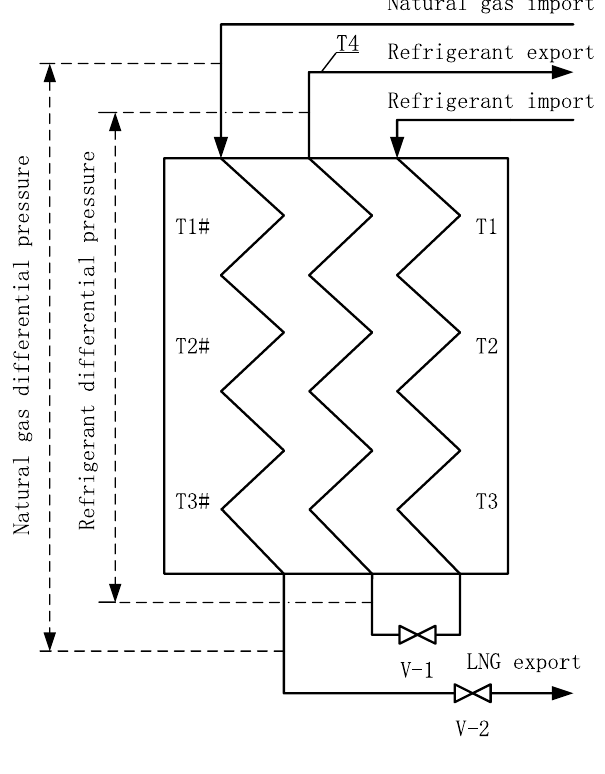
Fig. 1 Cold box process flow chart